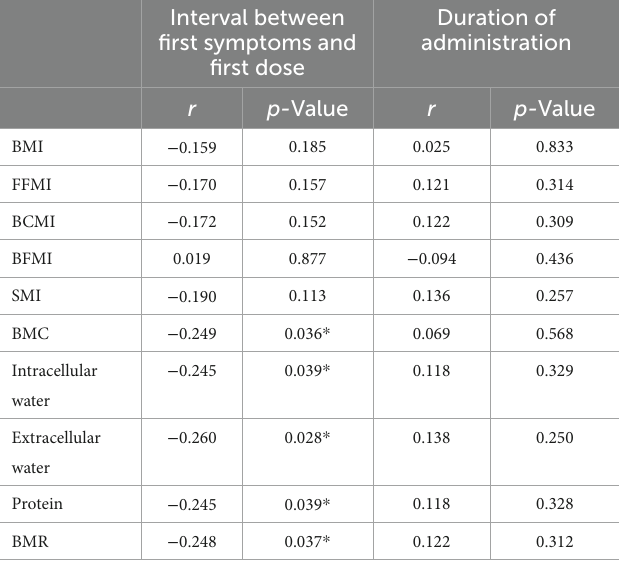
BMI, body mass index; FFMI, fat-free mass index; BFMI, body fat mass index; BCMI, body cell mass index; SMI, skeletal muscle mass index; BMC, bone mineral content; BMR, basal metabolic